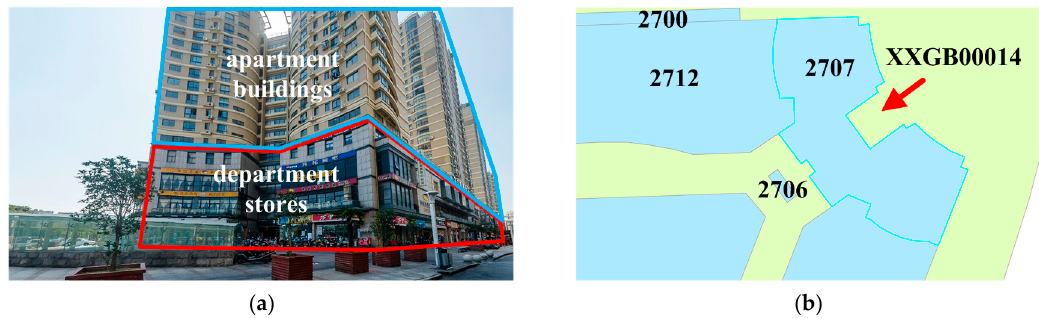
Figure 18. A mixed-use building ( a ) on Pozi Street represented on a 2D cadastral map ( b ).